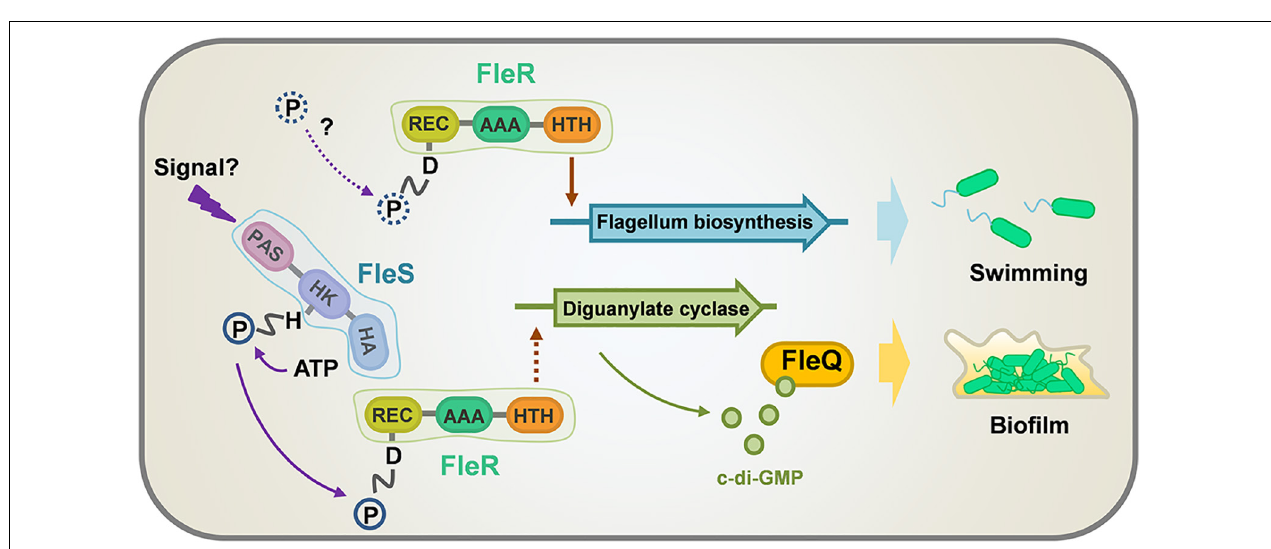
FIGURE 8 | A model illustrating the regulation of swimming motility and biofilm formation by FleS and FleR in PAO1. Biofilm formation is regulated by both FleS and FleR in a c-di-GMP dependent manner which is mediated by another transcription factor FleQ. However, swimming motility is regulated discrepantly by FleS and FleR. FleR is demonstrated as a key regulator to independently control the biosynthesis of flagellum which is essential to support bacterial swimming, while FleS moderately regulates swimming motility through undetermined mechanisms. Dot lines indicate uncertain signaling